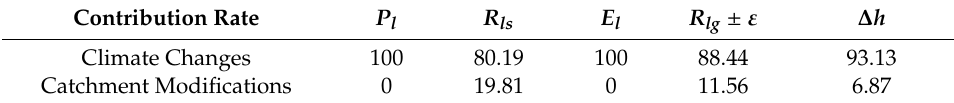
Table 11. Contribution rate of the hydro-climatic